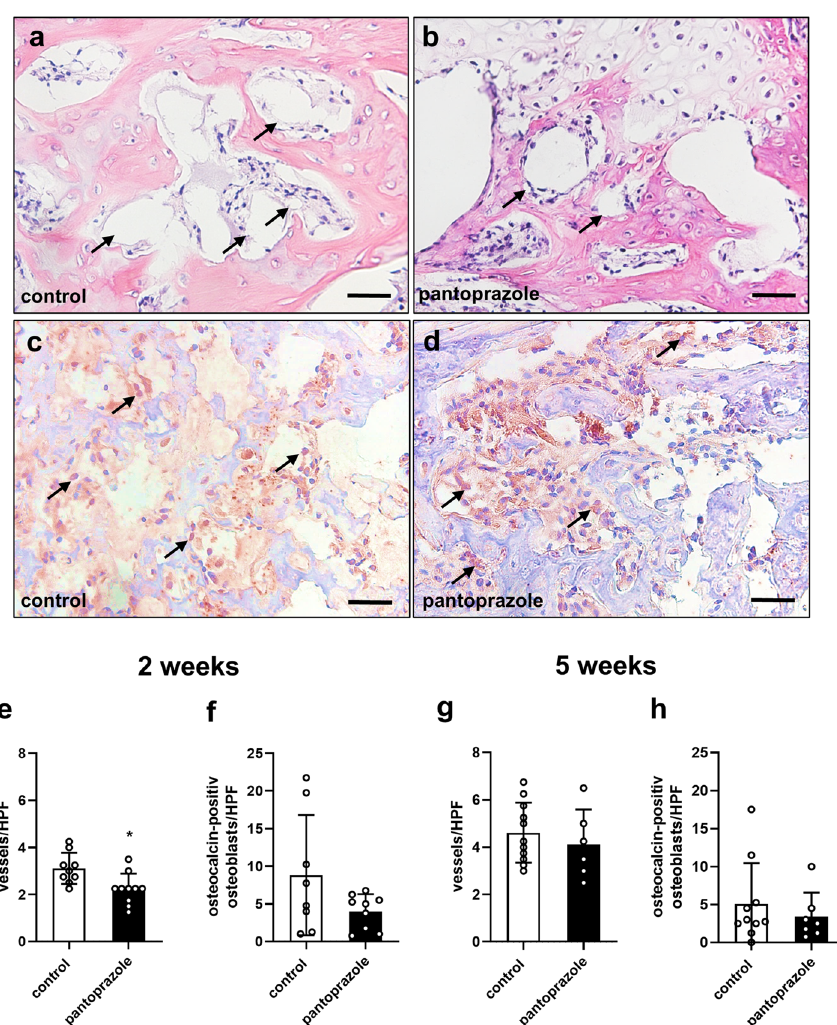
Figure 5. Histological analysis of vascularization and osteoblastogenesis. Representative histological sections of microvessels (arrows) at 2 weeks ( a , b ) and osteocalcin-positive osteoblasts at 2 weeks ( c , d ) after fracture healing in controls and pantoprazole-treated animal. Scale bars: 50 µm. Quantitative analysis of the number of microvessels ( e , g ) and osteocalcin-positive osteoblasts ( f , h ) per high-power field ( HPF ) in the callus tissue at 2 weeks ( e , f ) and 5 weeks ( g , h ) of controls (white bars) and pantoprazole-treated animals (black bars). Means ± SD; n = 6–11; *p < 0.05 vs.